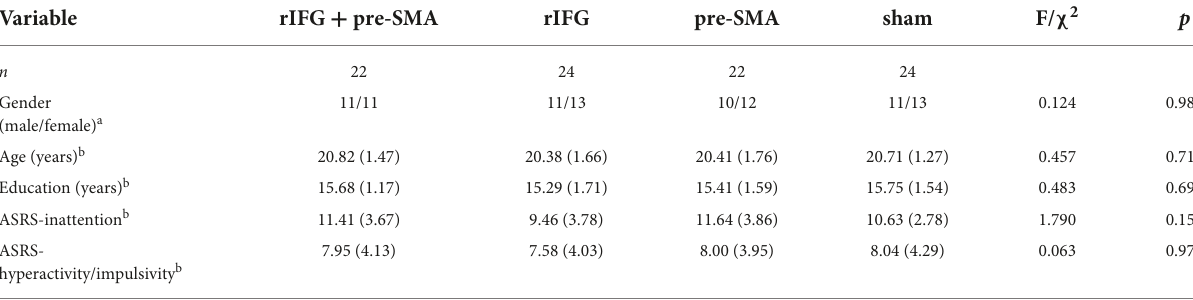
TABLE 1 Basic characteristics of participants (numbers or means and standard deviations).